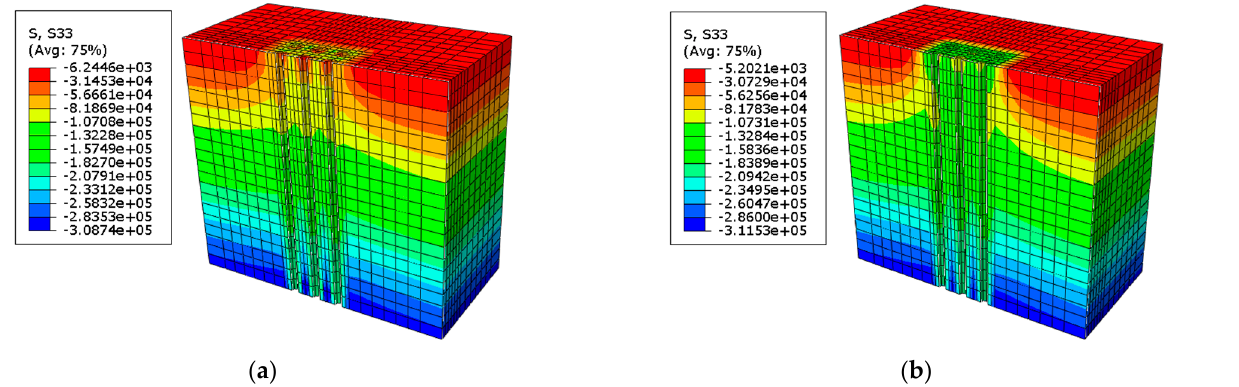
Figure 18. Soil pressure of a composite foundation (Pa): ( a ) Case 3; ( b ) Case 4.